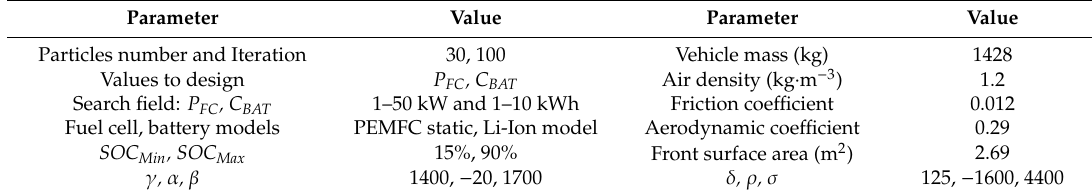
Table 1. Methodology and vehicle